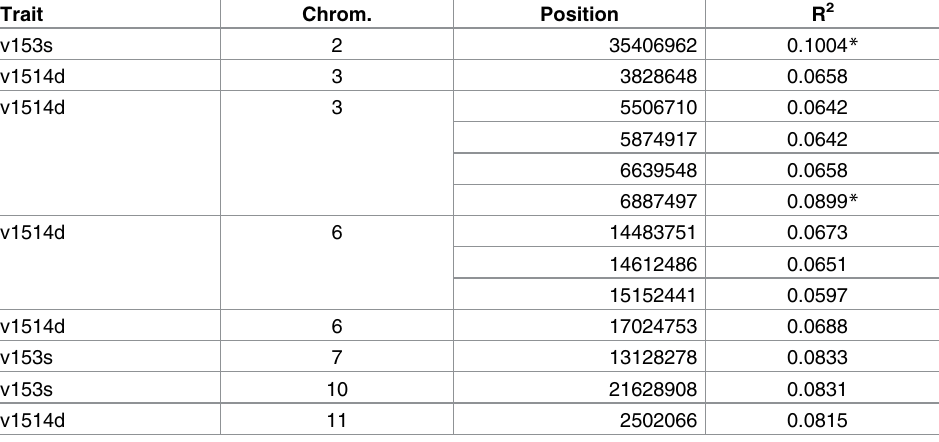
Table 4. SNPs markerswhith p -values that satisfied the FDR criterion with q = 0.1 for the japonica varietiesgroup. The effect of each locus is estimated by the R 2 value. Trait Chrom. Position R 2 v153s 2 35406962 0.1004 * v1514d 3 3828648 0.0658 v1514d 3 5506710 0.0642 5874917 0.0642 6639548 0.0658 6887497 0.0899 * v1514d 6 14483751 0.0673 14612486 15152441 0.0597 v1514d 6 17024753 0.0688 v153s 7 13128278 0.0833 v153s 10 21628908 0.0831 v1514d 11 2502066 0.0815 V15, coleoptile growth rate in 21 d at 15˚C; V1514d, coleoptile growth rate in 14 d at 15˚C; V153w, coleoptile growth rate in the 3 rd week of the trial at